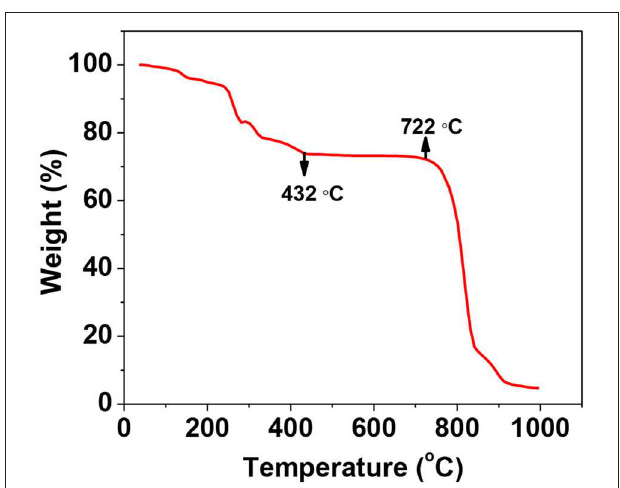
FIGURE 1 | Schematic of gas sensing measurement.